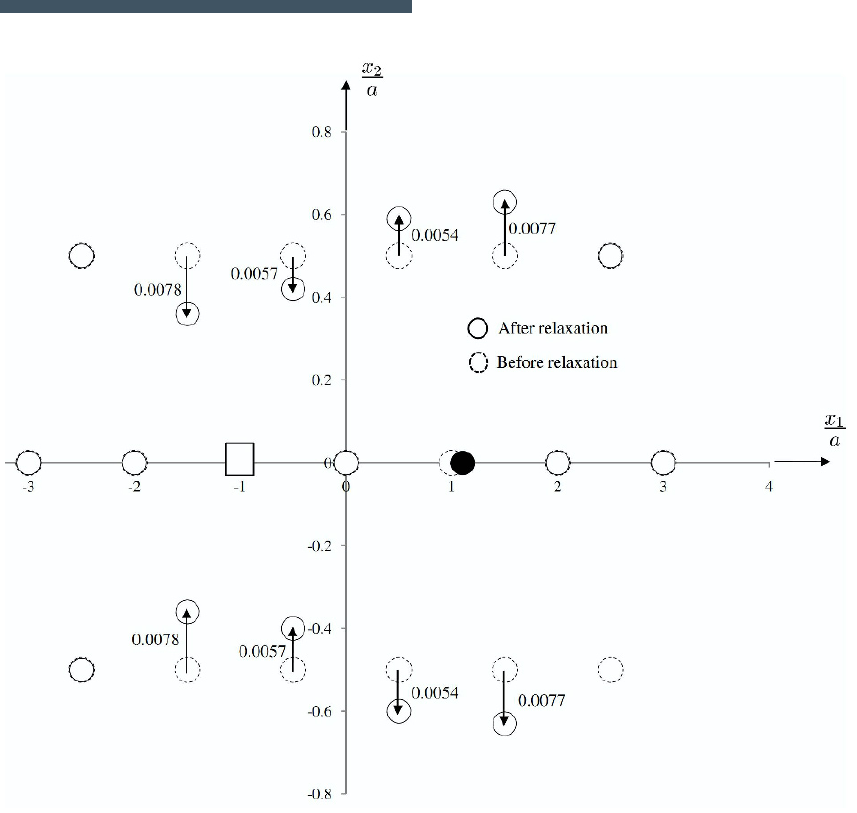
Figure 5. The in-plane displacements of the atoms near the dopant and a vacancy for L